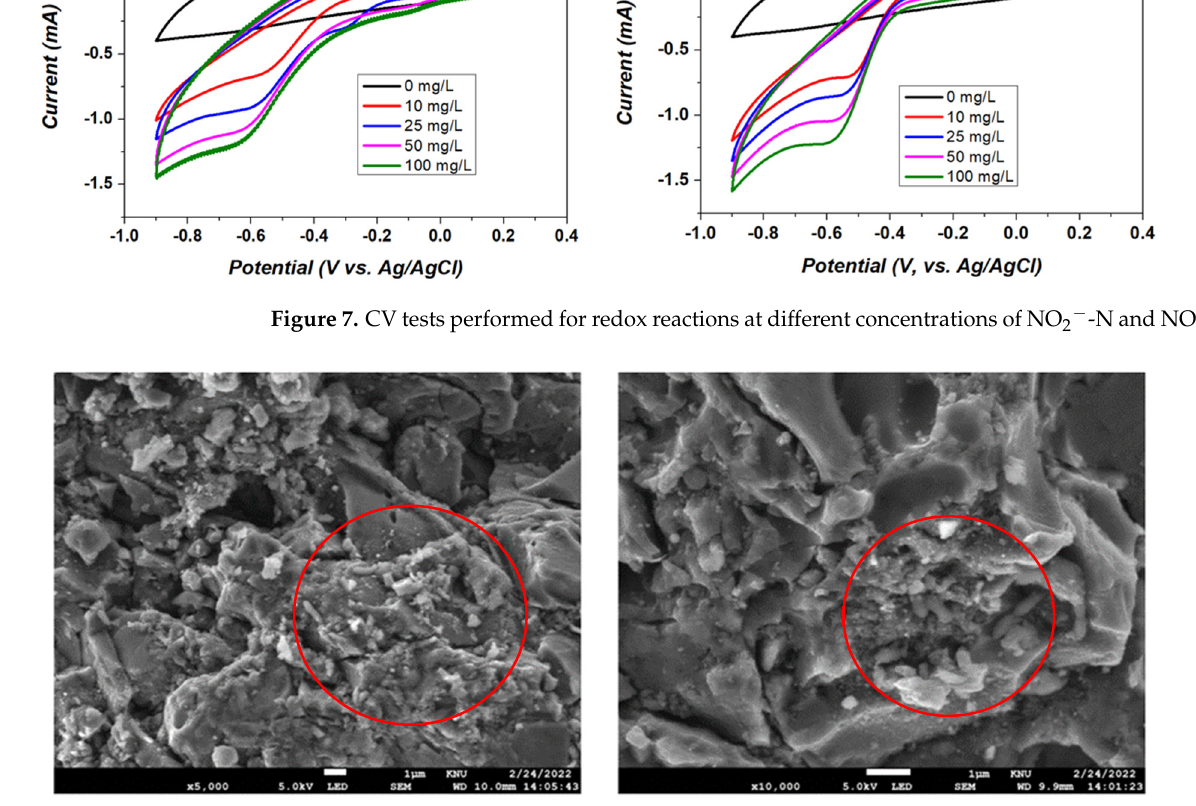
Figure 8. SEM images of bacteria grown on enriched